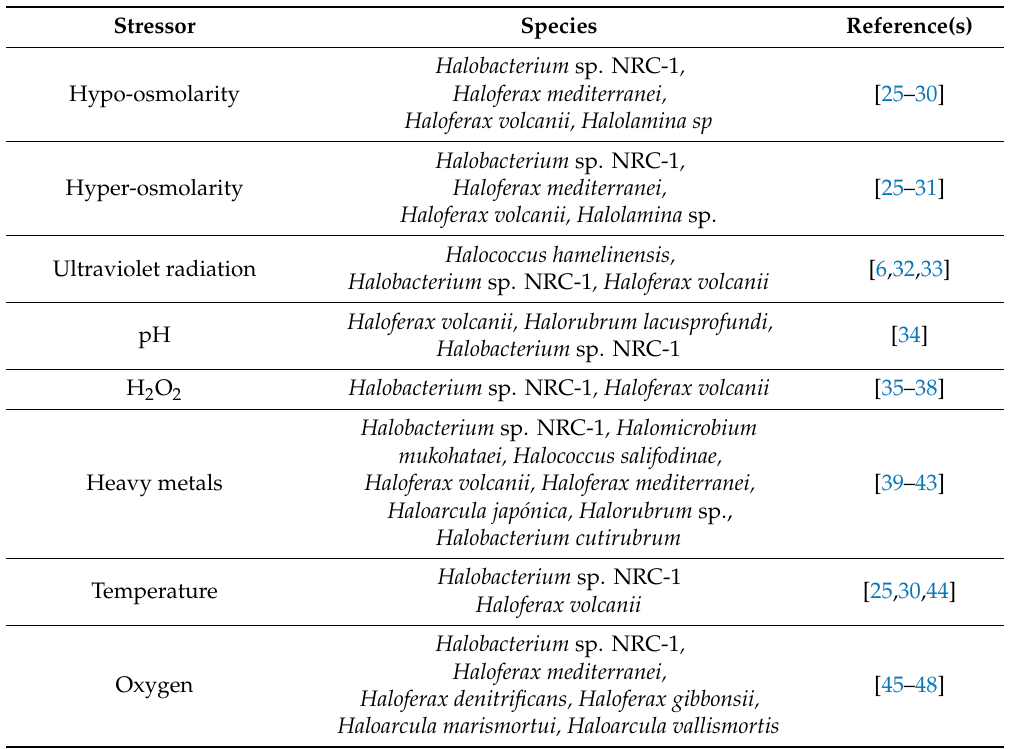
Table 1. Examples of the most studied stressors tested in halophilic archaeal